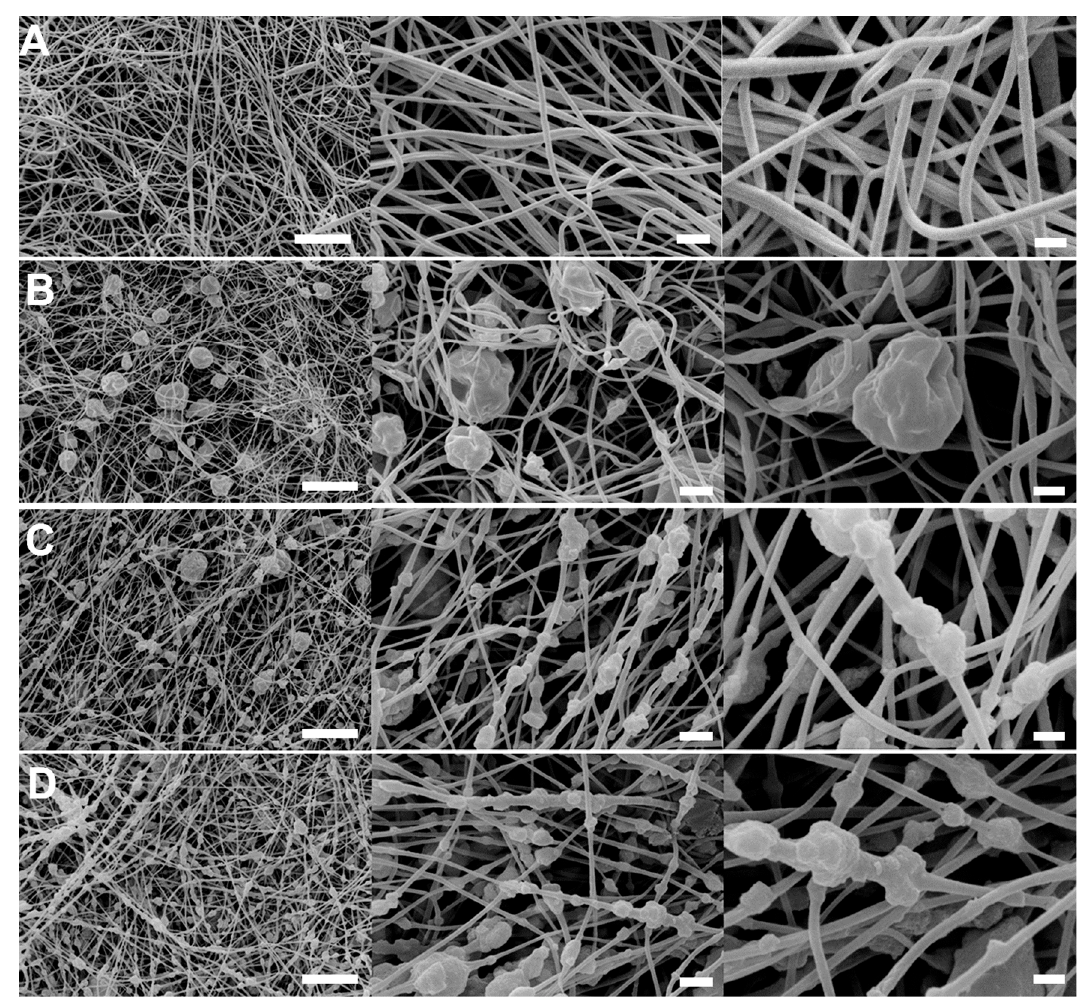
Figure 1. SEM images acquired at different magnifications of: ( A ) PAN; ( B ) PAN+TiO 2 ; ( C ) PAN + Au/TiO 2 and ( D ) PAN + AuPd/TiO 2 . Scale bars: 10 µm (first column); 2 µm (second column) and 1 µm (third column).